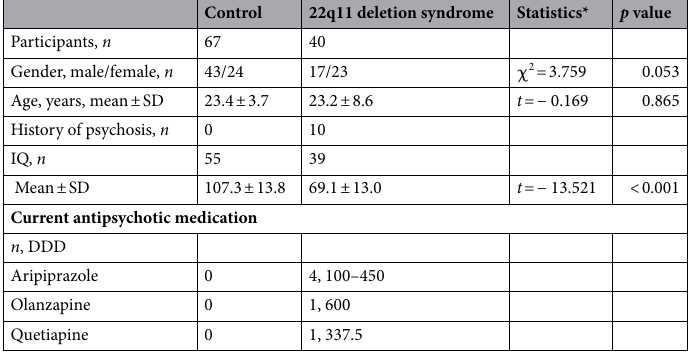
Table 1. Demographic data of study population. *Between-group differences were tested with a two-sample t -test for variables age and IQ and a Chi-square test for gender. Dose equivalents are calculated based on defined daily doses